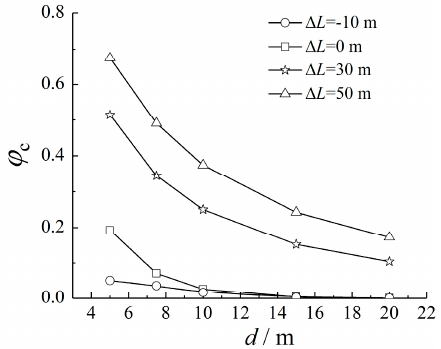
Figure 12. Impacts of lateral distance d on circulating air mixing ratio φ c .